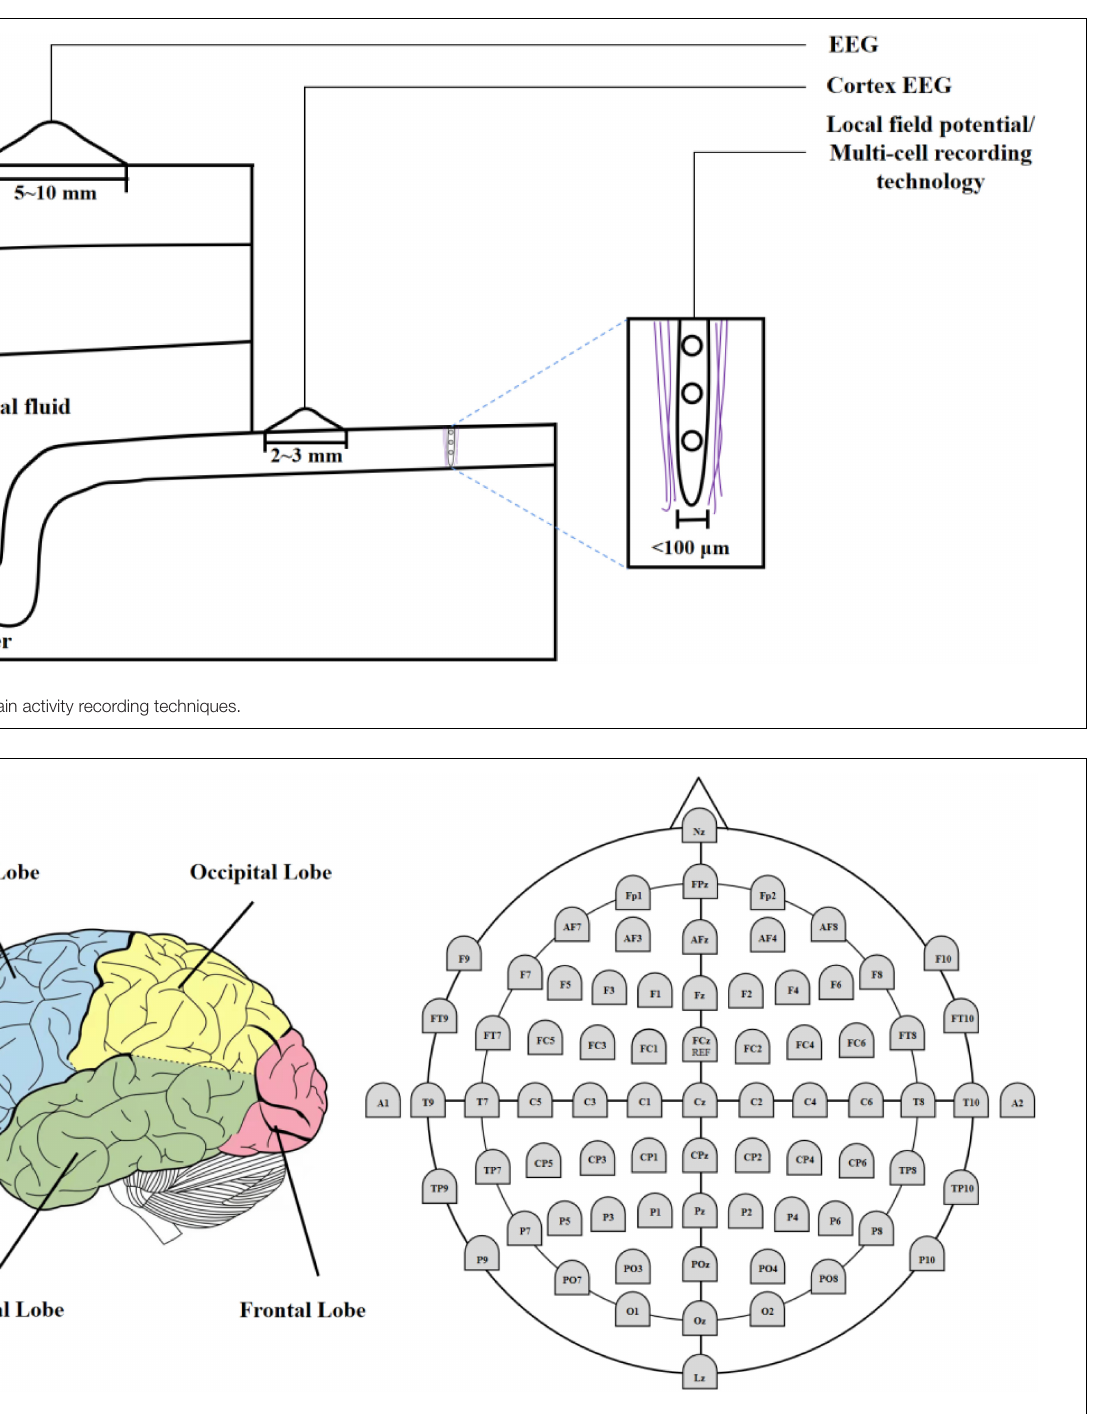
FIGURE 3 | EEG 10-20 international